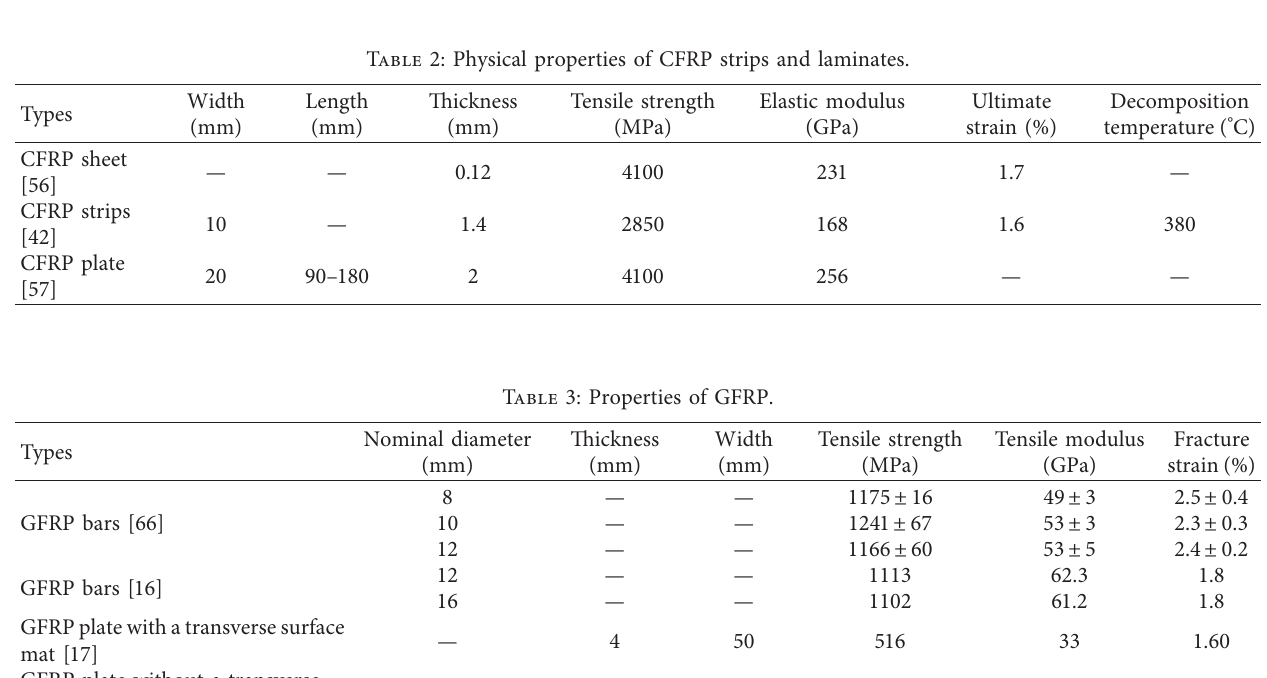
Table 2: Physical properties of CFRP strips and laminates.